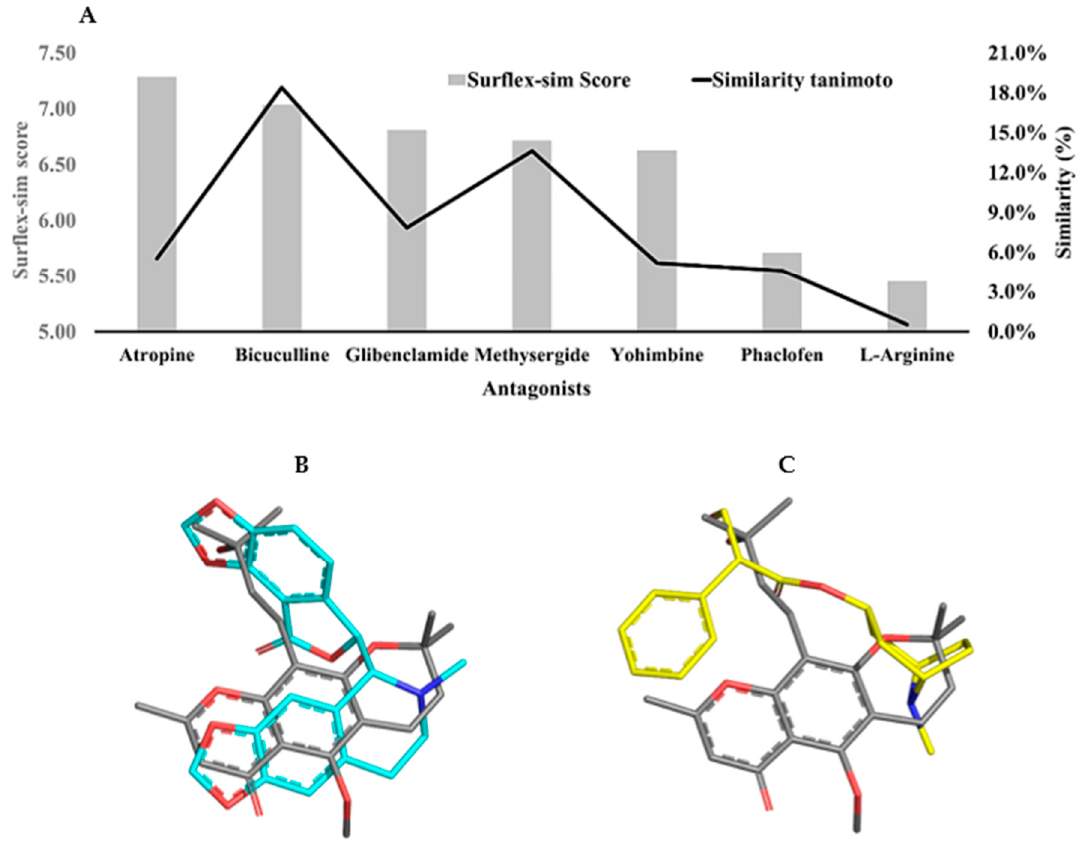
Figure 5. 2D and 3D similarity analysis of 5-CK and antinociception-related antagonists. ( A ) Tanimoto coefficient (%) and morphological similarity score of 5-CK against antagonists of receptors and channels involved with the endogenous analgesia system. ( B , C ) 3D alignment of 5-CK (gray sticks) on atropine (yellow sticks) and bicuculline (cyan sticks), the two most similar ligands according to Surflex-Sim (morphological similarity). Atom coloring scheme — nitrogen: blue, oxygen: red, carbon: gray, yellow or cyan, as described above.